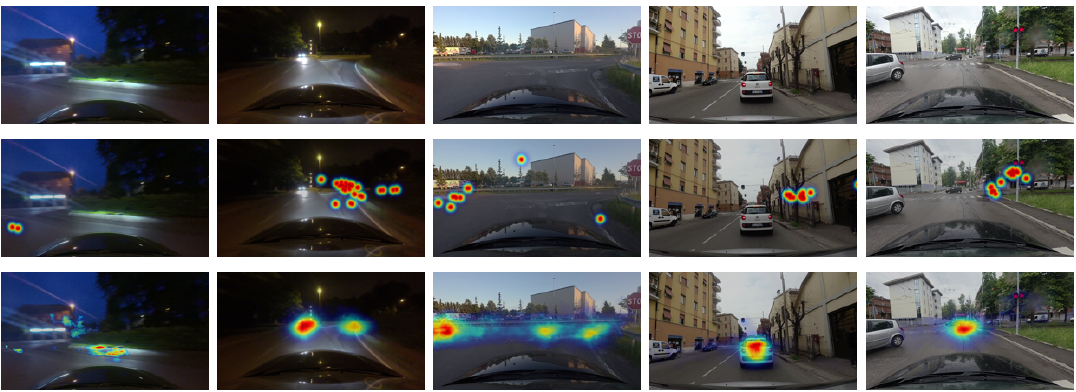
Figure 7. Failure cases. From top to bottom: input images, ground-truth attention map, and estimated attention map by the proposed